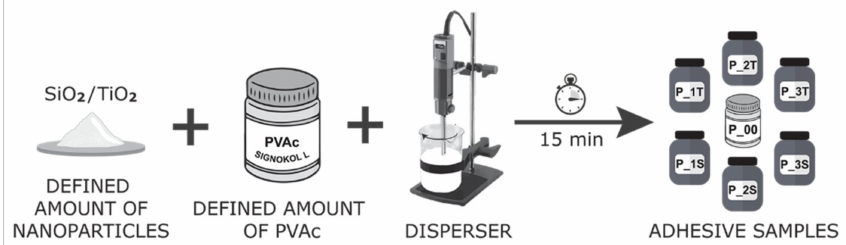
Figure 1. Mixing procedure for polyvinyl acetate (PVAc) modification with defined amount of SiO 2 and TiO 2 nanoparticles.